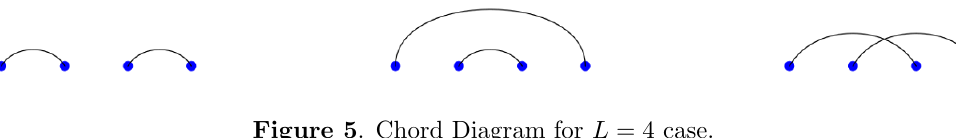
Figure 5 . Chord Diagram for L = 4